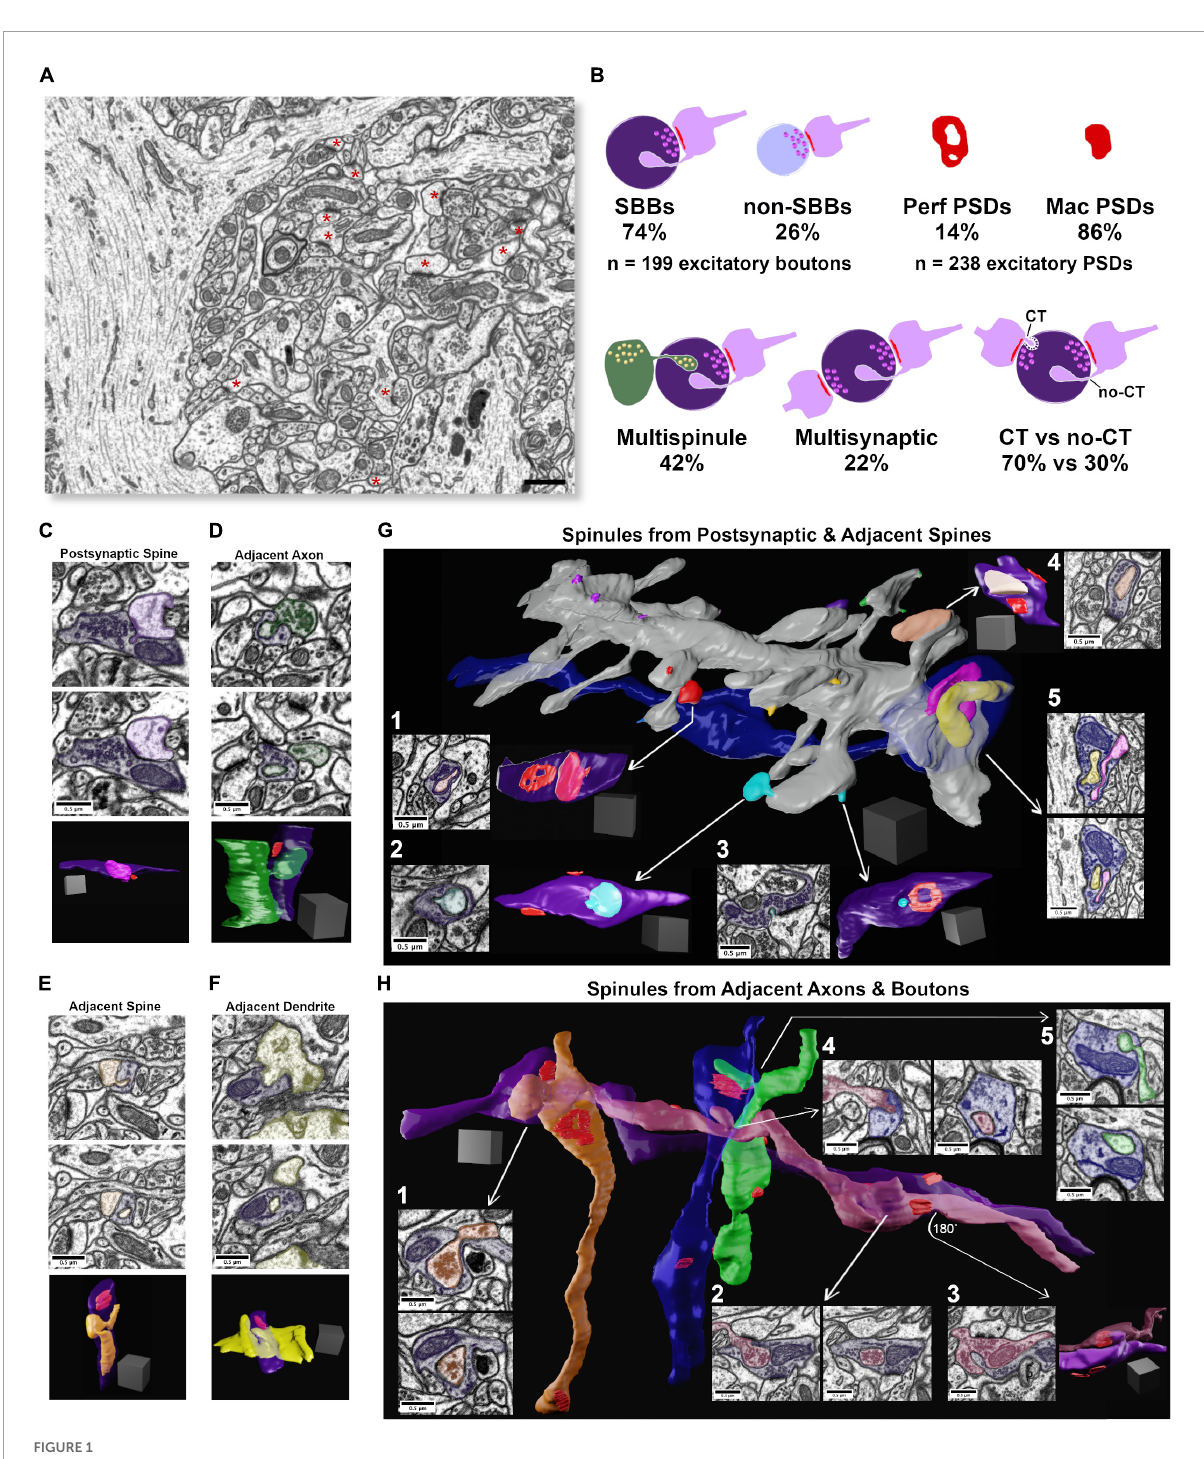
FIGURE1 Synaptic spinules are fundamental components of excitatory synapses in CA1. (A) Single image from the 5 nm isotropic FIB-SEM image volume of CA1 hippocampus. Excitatory asymmetric postsynaptic densities (PSDs) are indicated by a red asterisk. Note the large apical pyramidal cell dendrites that flank the left and right sides of the image that reduce excitatory synapse density throughout this image volume. (B) Cartoon showing quantification of the percentage of excitatory presynaptic spinule-bearing boutons (SBBs), presynaptic boutons without spinules (non-SBBs), perforated postsynaptic densities (Perf PSDs), macular PSDs, SBBs enveloping multiple spinules, SBBs with multiple synapses, and spinules with clathrin-coated tips (CT) versus those without clathrin-coats (no-CT). (C) Representative example of an SBB (purple) with CT spinules from its postsynaptic spine (PSs; pink) partner. Upper and middle panels are adjacent FIB-SEM images showing the invagination and envelopment of one of three PSs spinules into this SBB. Bottom panel shows the 3D reconstruction of this PSs projecting three spinules into the SBB. Note that this SBB forms a second synapse (PSD in red) with a second spine (not shown).